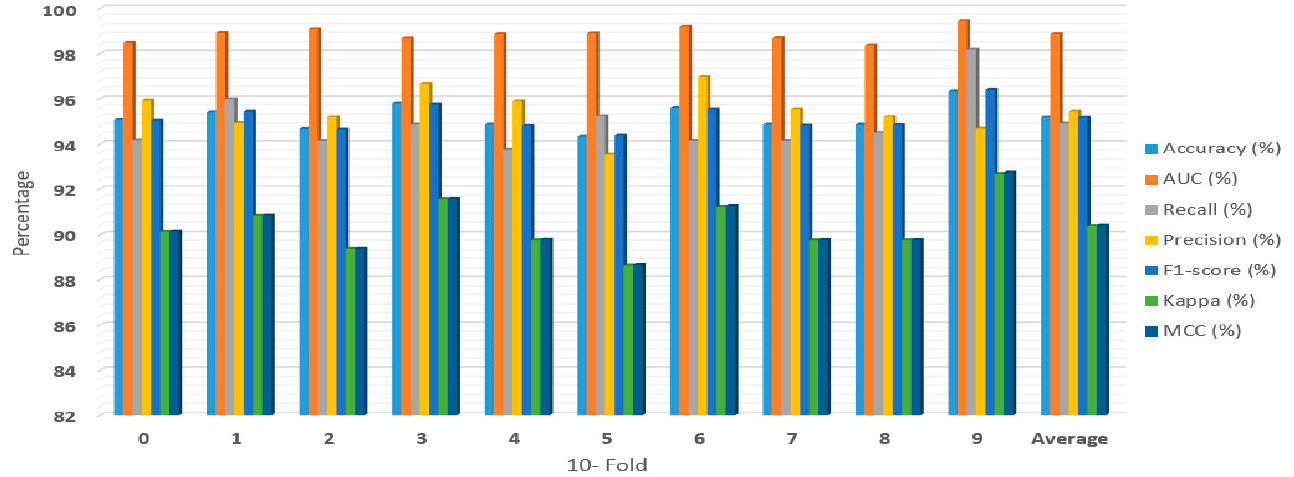
Figure 8. The metrics of the LightGBM model after tuning the hyper-parameters.